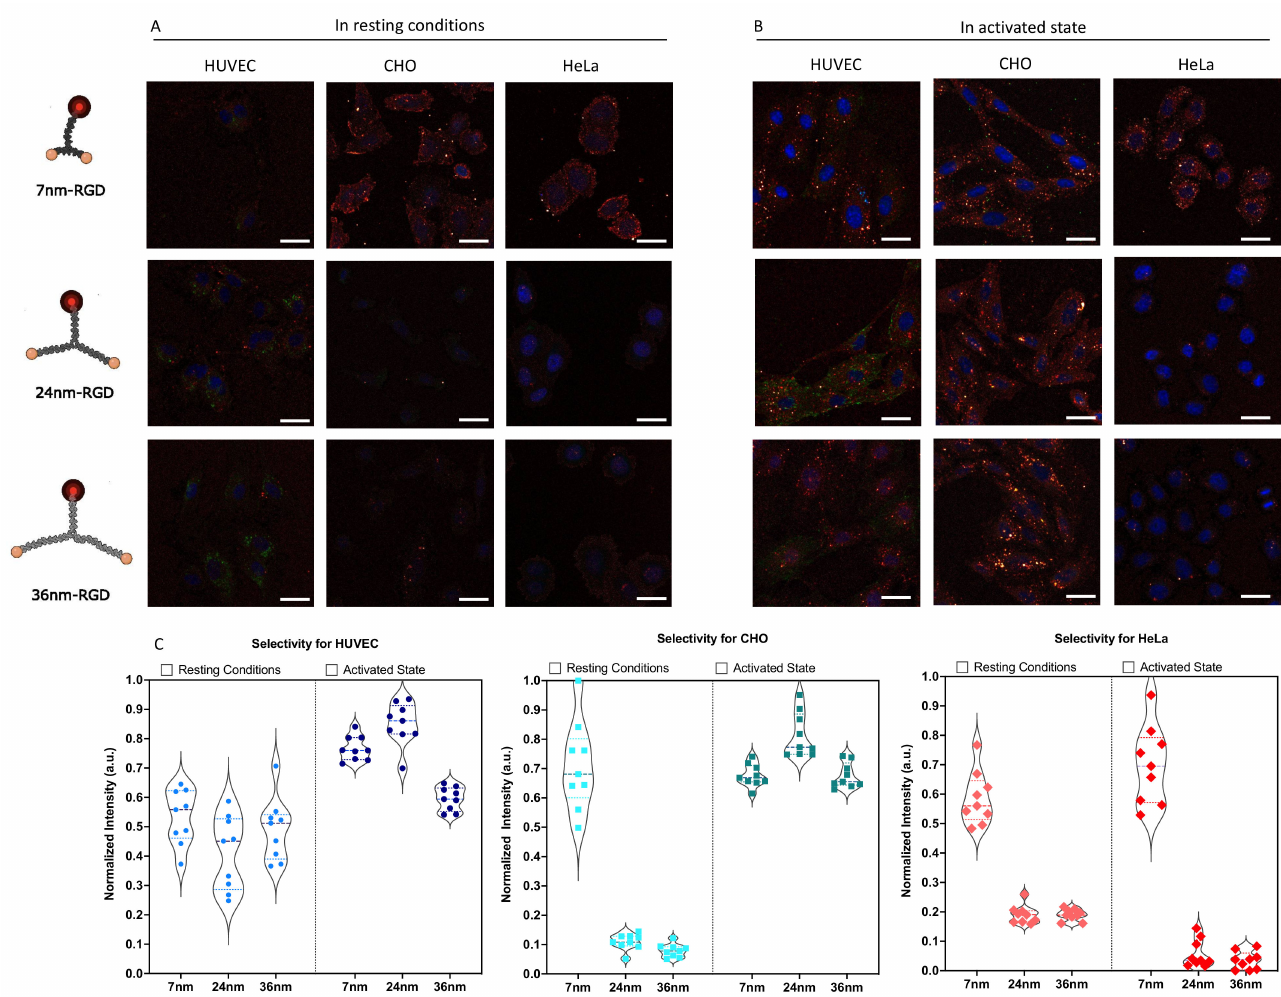
Figure 5. Confocal microscopy analysis of spatially constrained integrin staining. ( A ) Representative overview for non-activated cells ( B ) Representative overview for activated cells. Images show the DNA-analytes in red (Cy5 label), antibody-stained integrin in green (Alexa 488) and the nucleus in blue (DAPI). Scale bar = 30 µ m ( C ) Quantification of selective binding, in resting conditions and in activated state. Plotted is the globally normalized intensity of scaffold present within the cell boundaries from a Z-projection of confocal images, corrected for background. Data is quantified from nine independent image stacks containing multiple cells per image. A full statistical analysis can be found in Supplementary